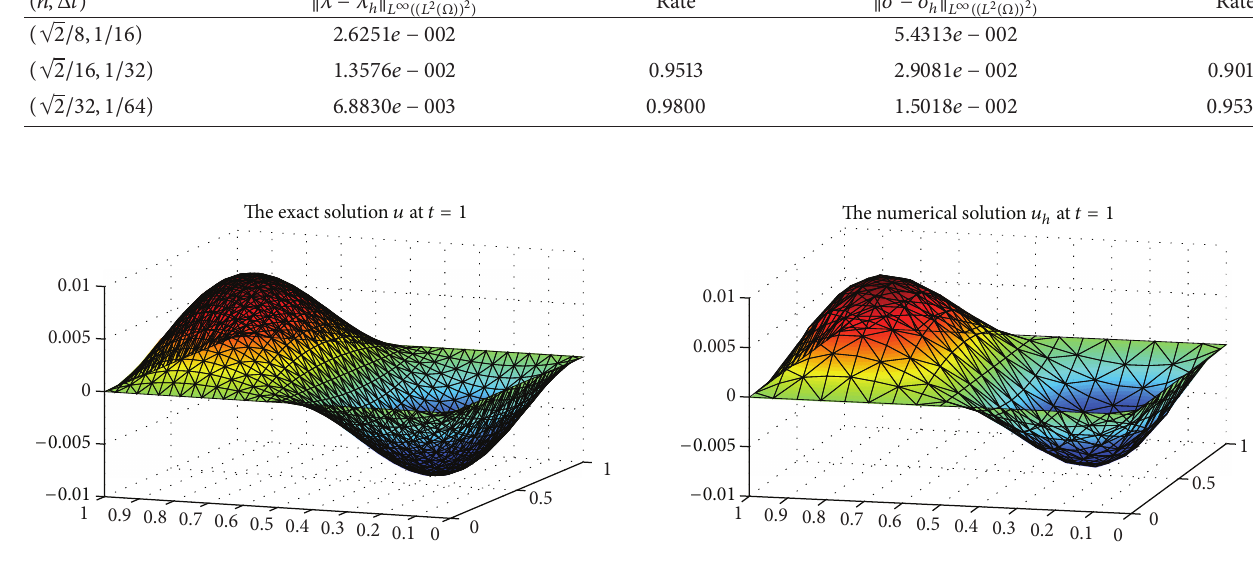
Figure 1: The surface for the exact solution 𝑢 . Figure 2: The surface for the numerical solution 𝑢 ℎ